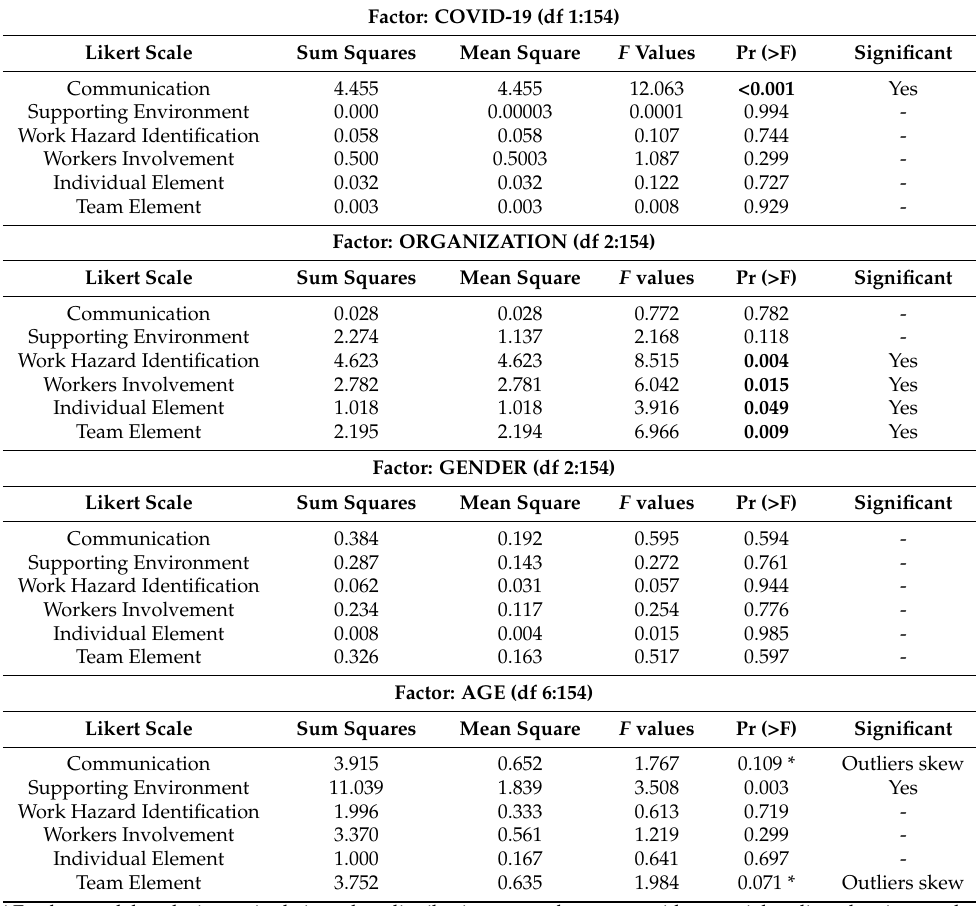
Table 4. Safety Climate Survey Likert Scale & Organization Elements ANOVA Results.